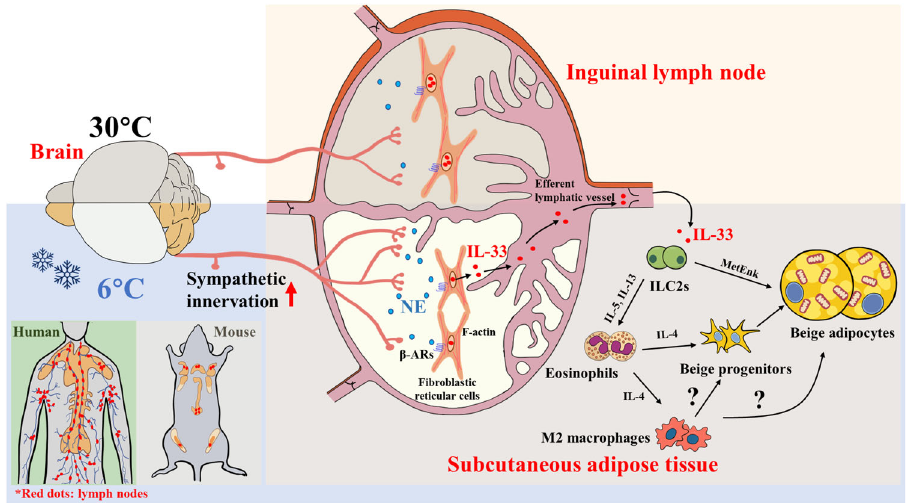
Fig. 8 | iLN couples sympathetic signaling and type 2 immune responses to mediate cold-induced beiging of scWAT by releasing IL-33 from FRCs. Cold exposure enhances sympathetic innervation of iLN, thereby releasing nor- epinephrine (NE) to act on beta adrenergic receptors ( β -ARs) in fi broblastic reti- cular cells (FRCs). Adrenergic stimulation induces mechanical response